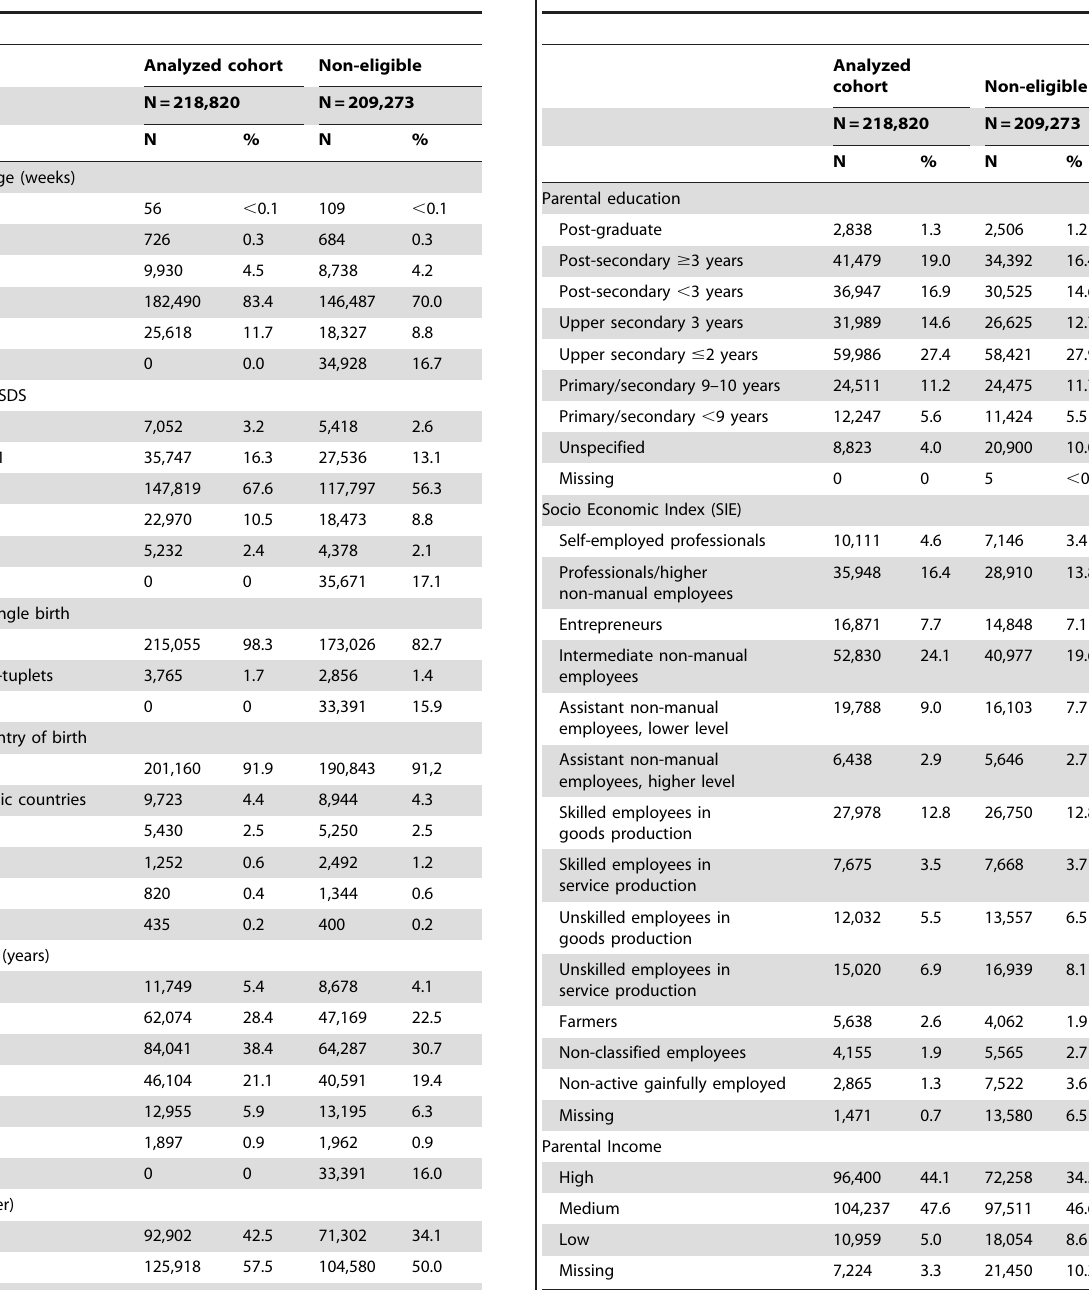
Table 1. Perinatal characteristics of analyzed cohort vs. non- eligible subjects.